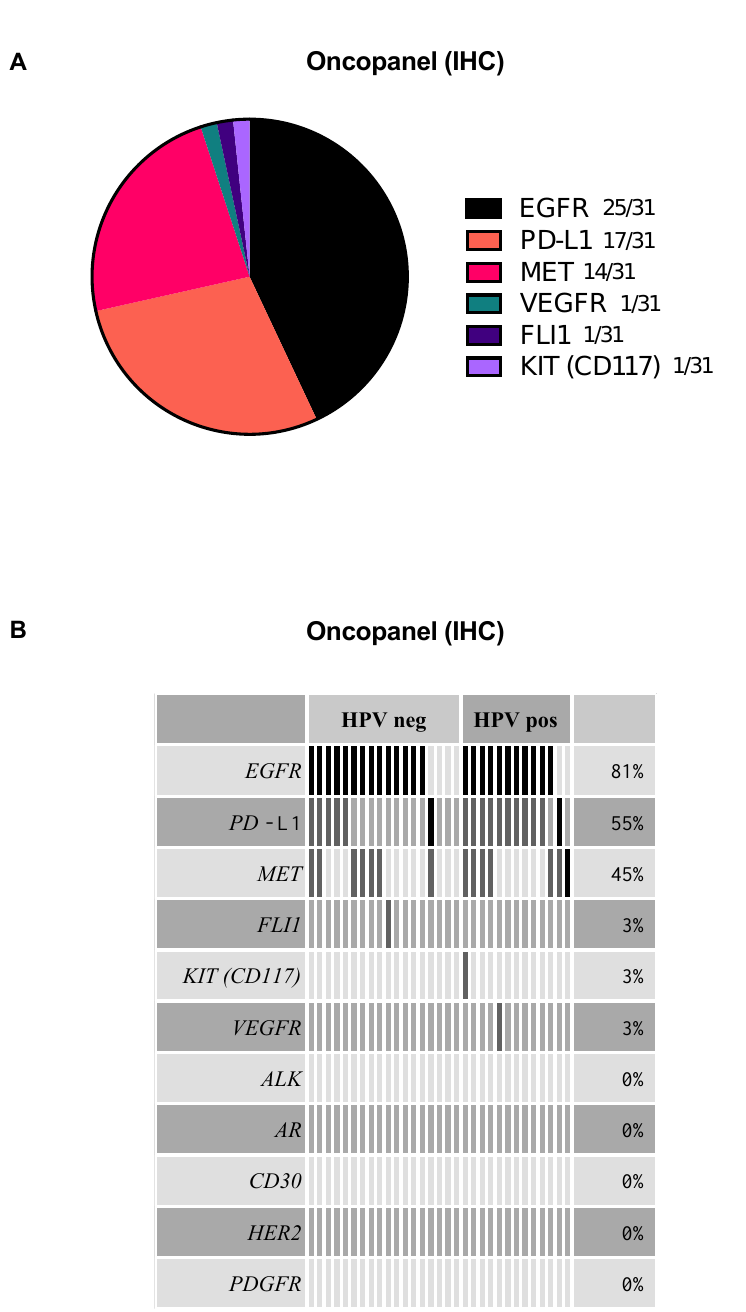
Figure 1. Results of the immunohistochemical approach (oncopanel) for 31 patient samples. ( A ) Pie chart displaying the distribution of marker expression. ( B ) AVAtar plot shows the markers’ distribution and their co-expression grouped by HPV status. The black bars show the first positive result per sample, while the grey bars depict a co-expression of a target in a specific sample.